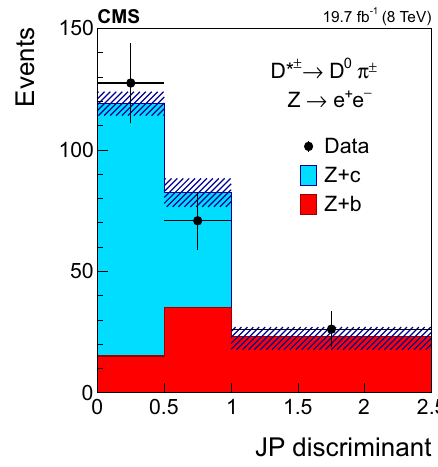
Vertical bars on data points represent the statistical uncertainty in the data. The hatched areas represent the sum in quadrature of the statistical uncertainties of the templates describing the two contributions (Z + c from W + c data events and Z + b from